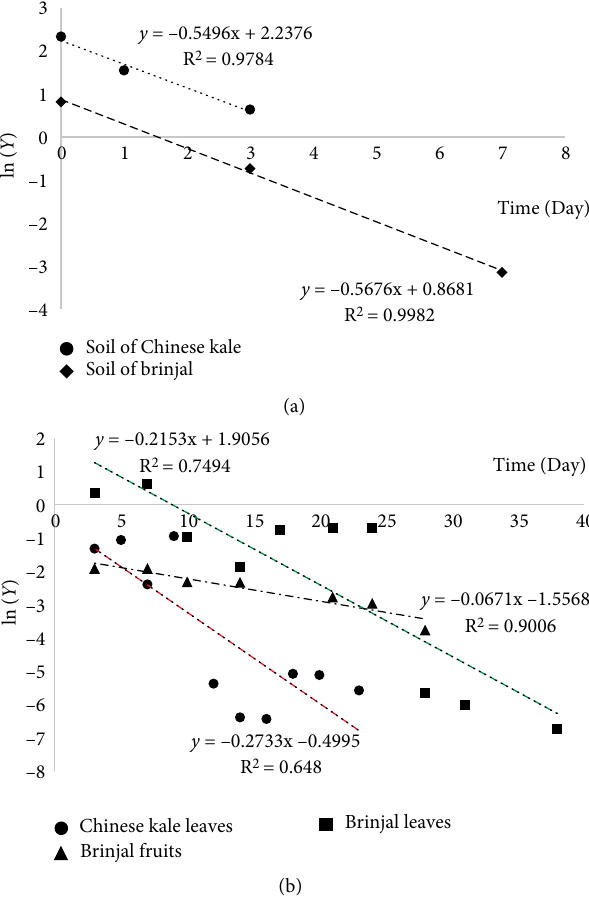
Figure 6: The regression models for the estimation of carbofuran half-life in (a) soils and (b)